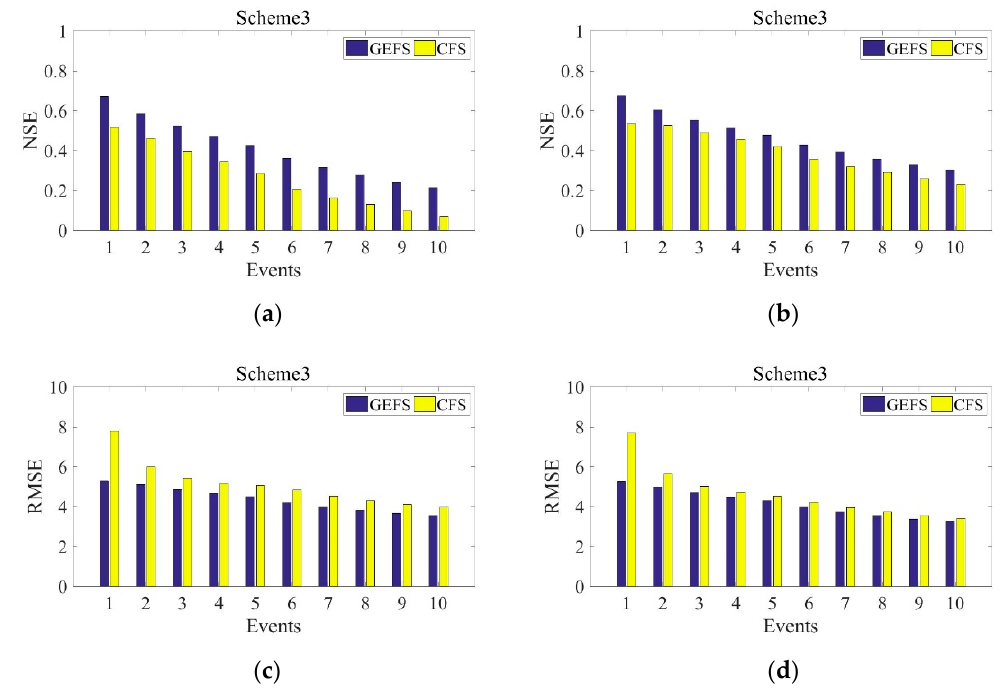
Figure 6. The evaluation results of Scheme 3: ( a ) the NSE of raw forecasts; ( b ) the NSE of post-processed forecasts; ( c ) the RMSE of raw forecasts; and ( d ) the RMSE of post-processed forecasts.